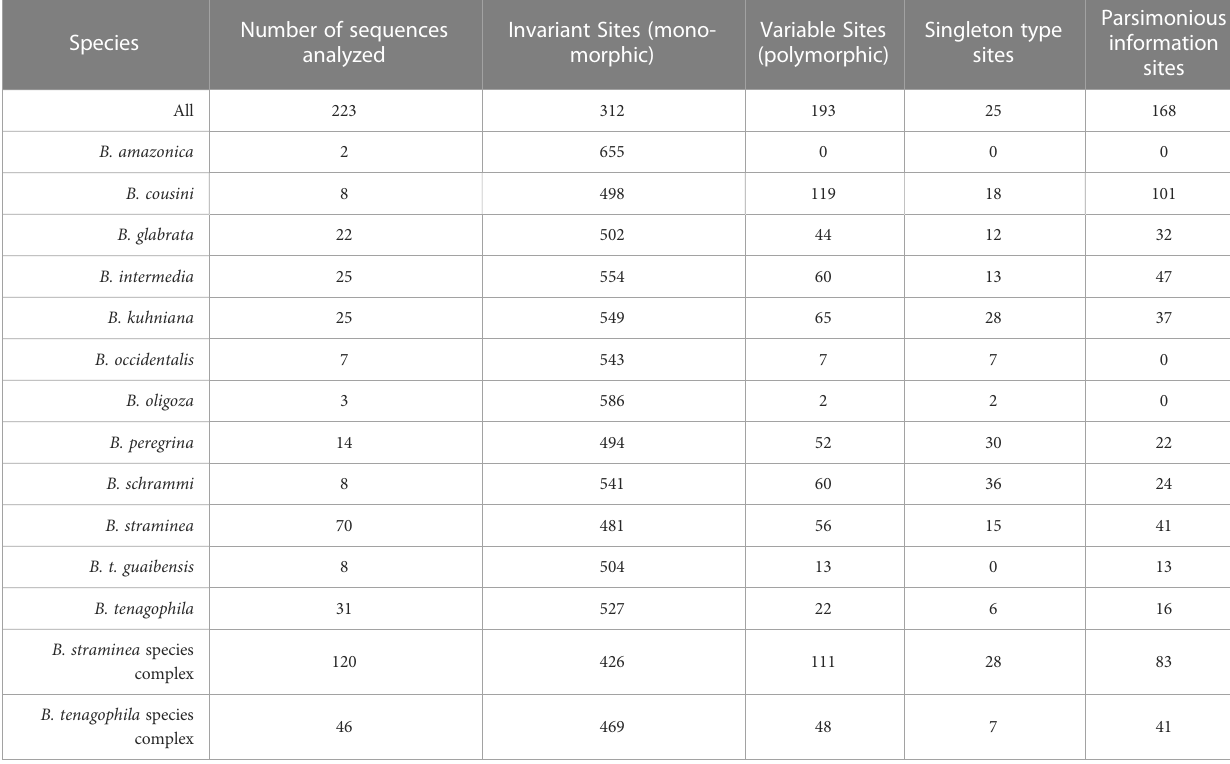
TABLE 1 Polymorphic sites in the partial sequences of the coi gene from populations of Biomphalaria .